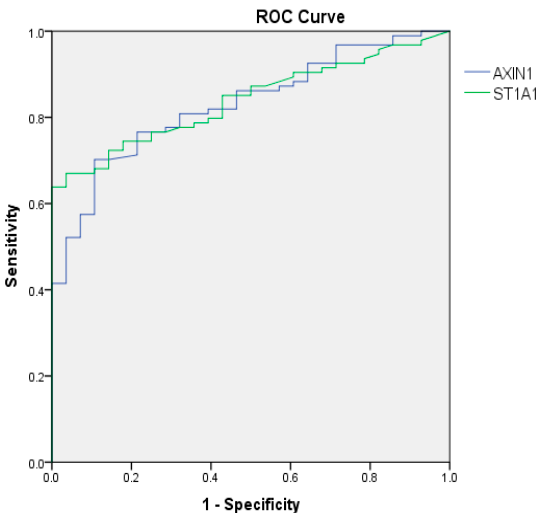
Figure 1. NPX levels in endometriosis and controls . NPX = normalized protein expression. The NPX unit is an arbitrary unit of concentrations. Figures indicate mean NPX value and 95% confidence interval of the mean value in each group; endometriosis ( N = 94), microscopic colitis ( N = 47) and healthy controls ( N = 28).